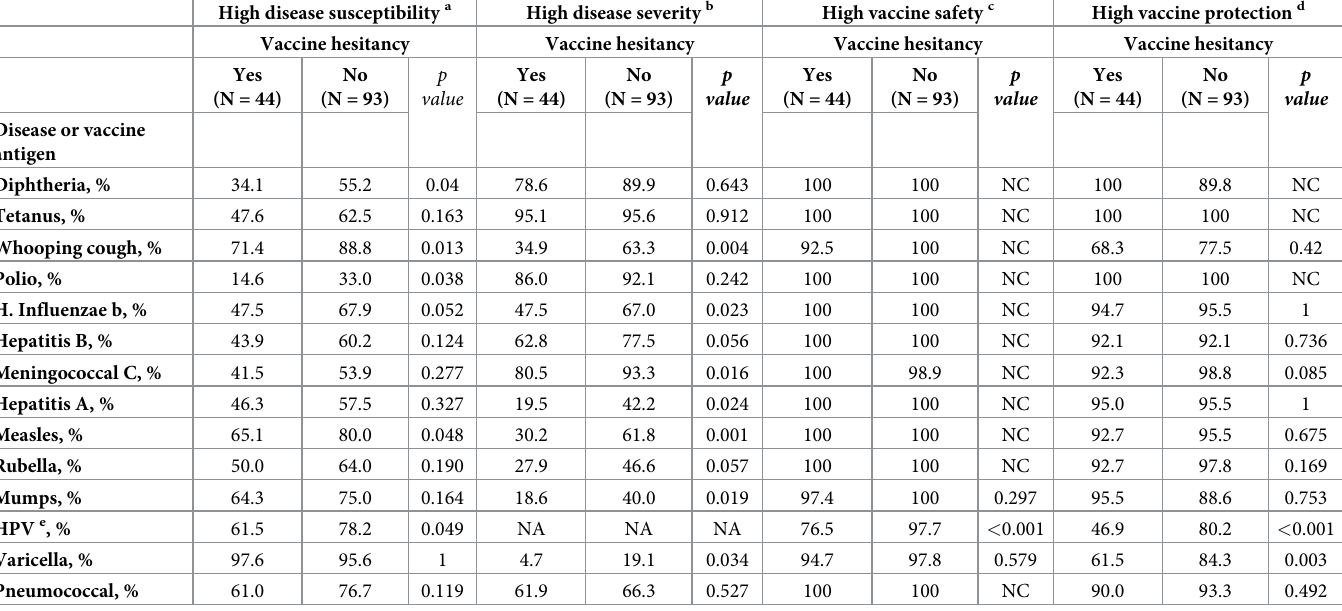
Table 2. Nurses’ views on disease susceptibility and severity, and vaccine safety and protection by hesitancy Barcelona 2016–17 (N = 137). High disease susceptibility